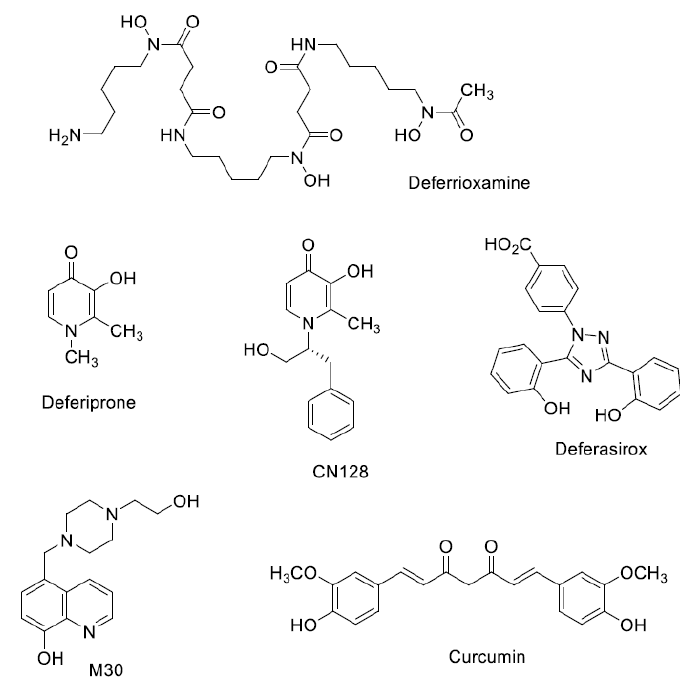
Figure 1. Chemical structures of iron chelators.